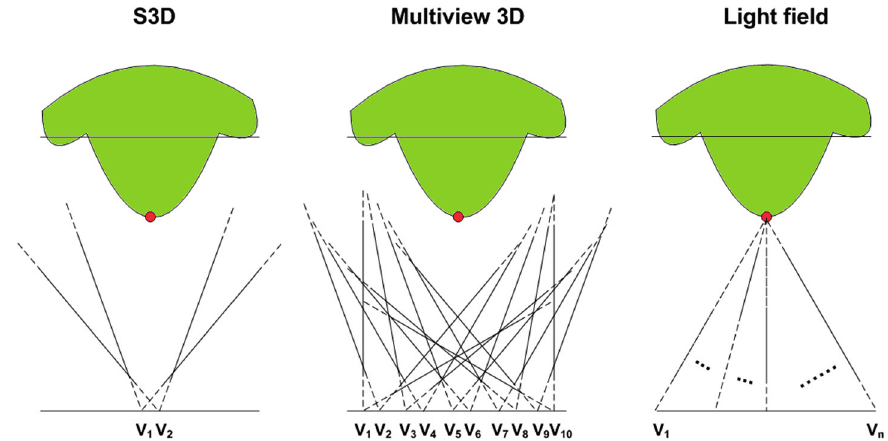
Figure 1. Displaying in 3D using Stereoscopic 3D (S3D), multiview 3D and light field technologies.